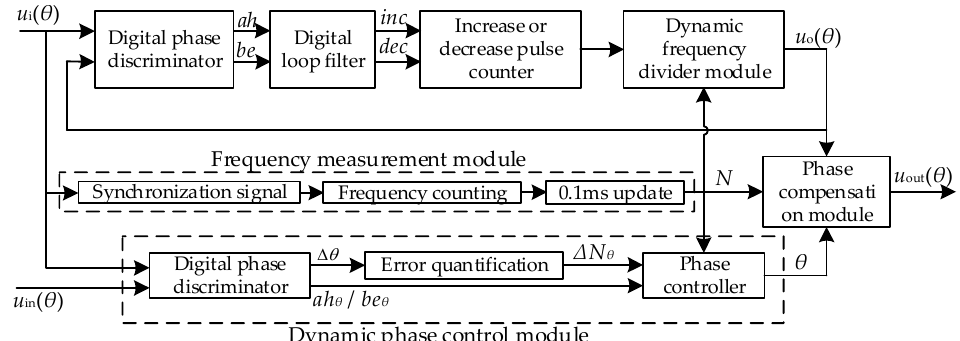
Figure 7. Block diagram of frequency-tracking control strategy based on transmitter current and voltage–current phase difference.